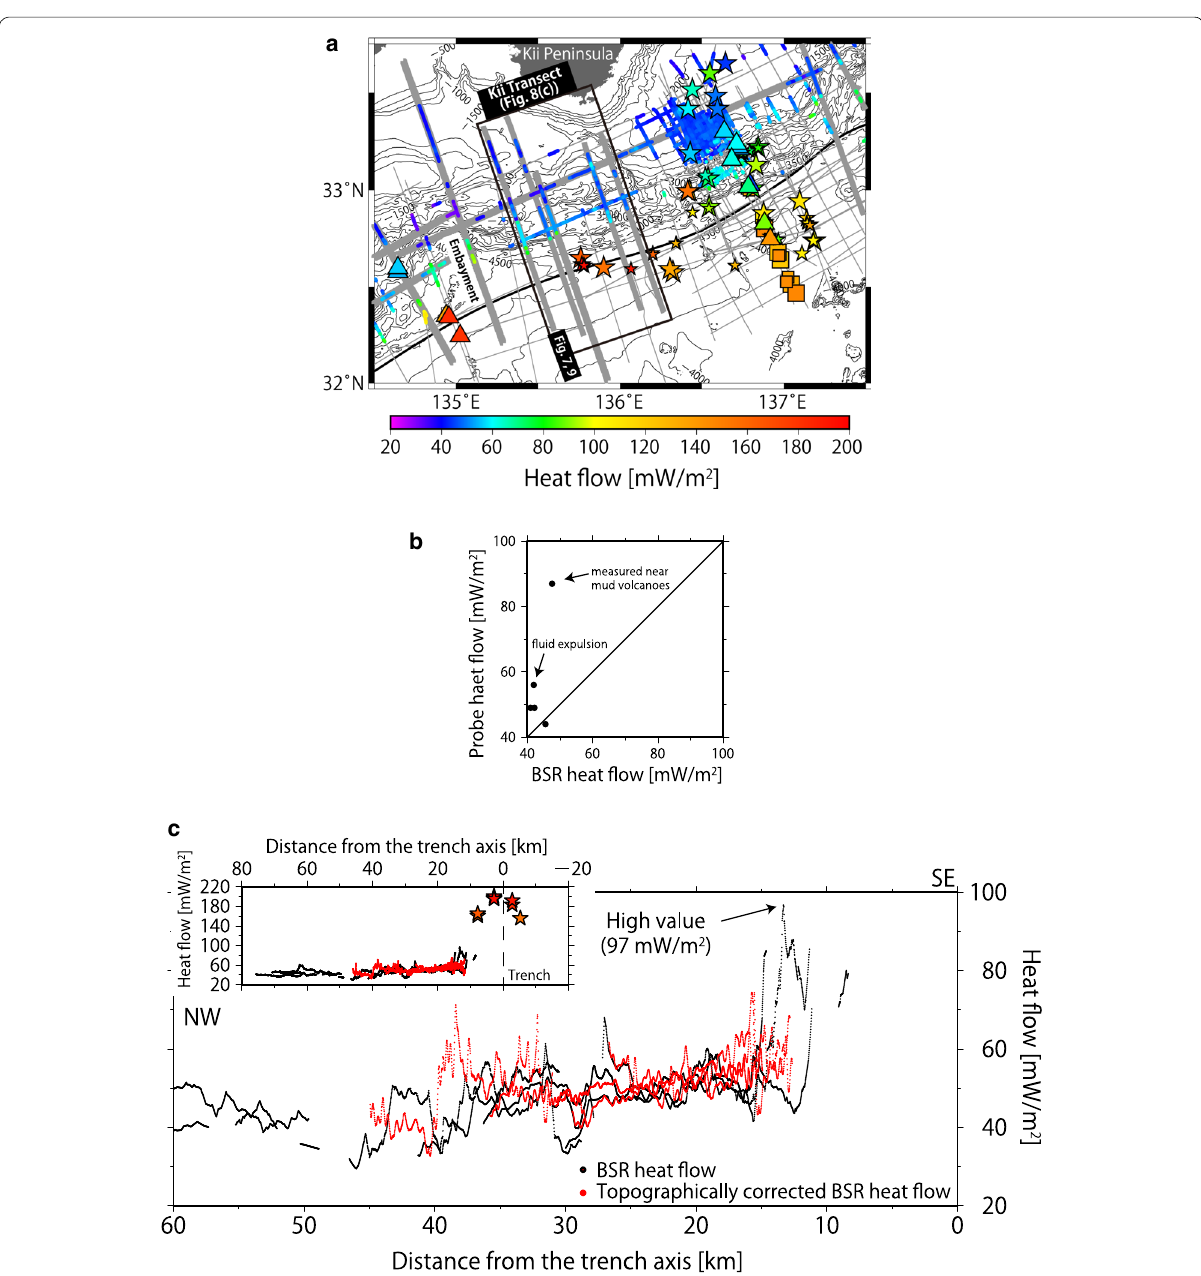
Fig. 8 BSR-derived heat flows. a Comparison of heat flows from the BSRs, probe measurements, and borehole measurements off the Kii Peninsula. Colored symbols indicate heat flows measured by probes [squares from Kinoshita et al. (2008), stars from Hamamoto et al. (2011)], boreholes [trian- gles from Shipboard Scientific Party (1975, 1986a, b), Taira et al. (1991), Moore et al. (2001), Harris et al. (2011), and Marcaillou et al. (2012)], and BSRs (colored dots from this study). Larger sizes of the square and star symbols reflect better data quality as defined by the authors. Gray lines represent survey lines, and thick lines represent modeled survey lines. The black frame bounds a 60 km wide area encompassing five modeling sections and probe data. b Cross plot showing the topographically uncorrected BSR-derived heat flow and probe heat flow within approximately 1 km of the Kumano Basin. The differences between the heat flows from BSRs and from probes in neighboring areas fall within a range of 20%, except at two sites, which are thought to be affected by fluid expulsion (Hamamoto et al. 2011). c Heat flow profiles along the transect bounded by the black frame in ( a ). The profiles include topographically uncorrected (black dots) and corrected (red dots) BSR-derived heat flows of five modeled seismic lines (gray thick lines within the black frame in ( a ). Although a sudden rise/drop of the heat flow is observed in the uncorrected data at distances from the trench axis of approximately 15 and 30 km, the change is tempered by topographic correction. The inset figure shows the topographically uncorrected (black dots) and corrected (red dots) BSR-derived heat flows of the five modeled seismic lines and probe heat flows [stars from Hama- moto et al. (2011)] from the black frame of ( a